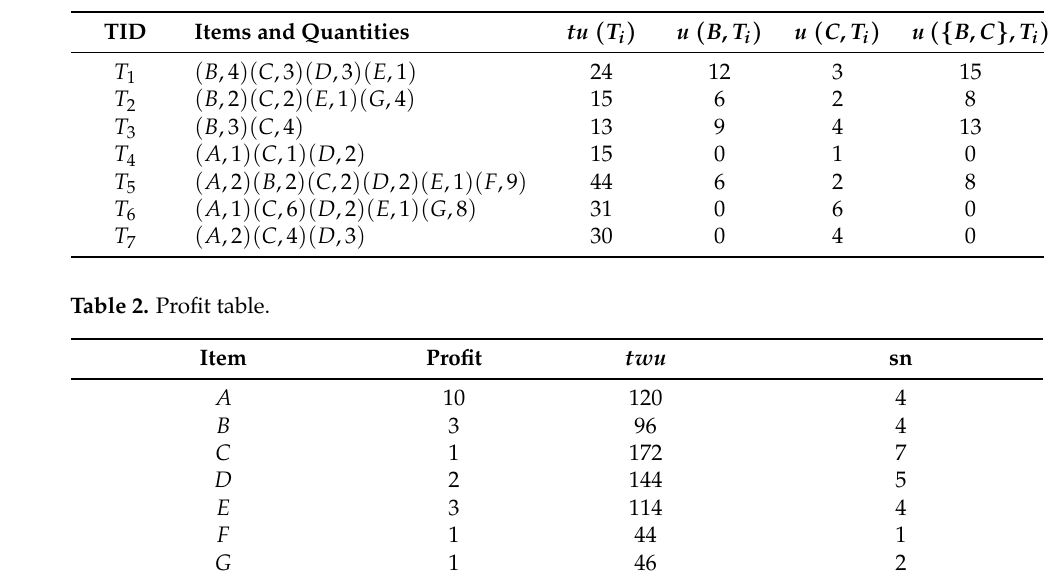
Table 1. An example database.